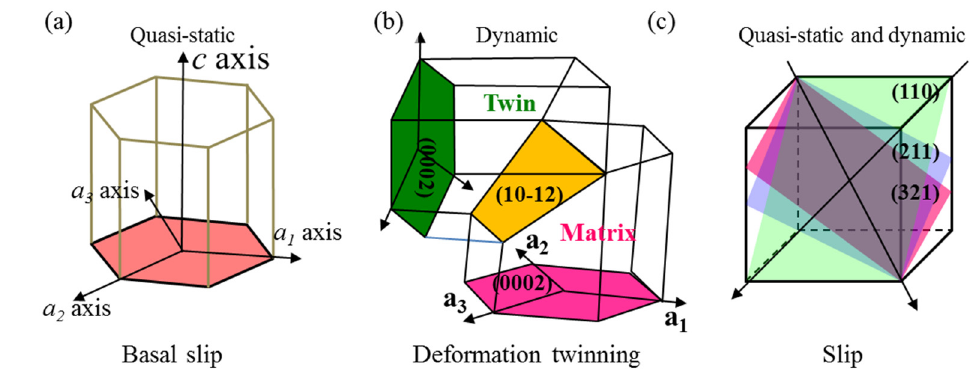
Figure 6. Schematic diagram of deformation modes in α - β Ti alloys. ( a ) HCP α phase at quasi-static loading; ( b ) HCP α phase at dynamic loading; ( c ) BCC β phase at quasi-static and dynamic loading.